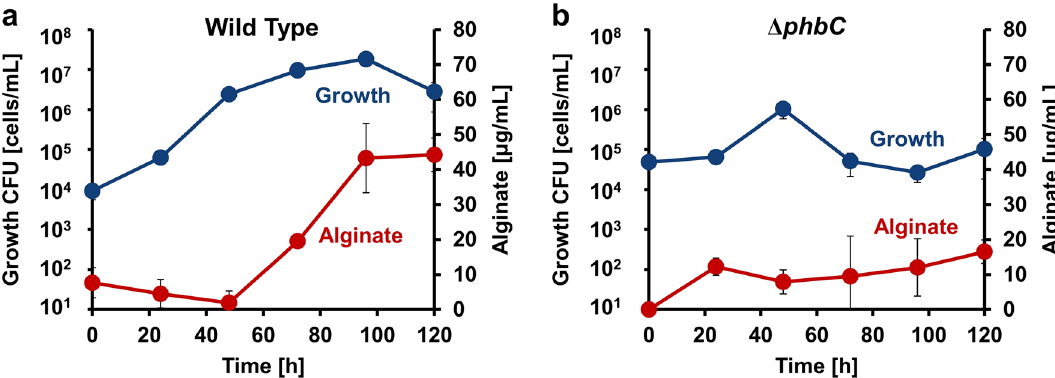
Figure 3. Alginate production from crude glycerol. ( a ) Growth and alginate production (wild-type cells). Blue and red-colored circles represent growth and alginate concentration, respectively. ( b ) Growth and alginate production (mutant Δ phbC cells). Blue and red-colored circles represent growth and alginate concentration, respectively.